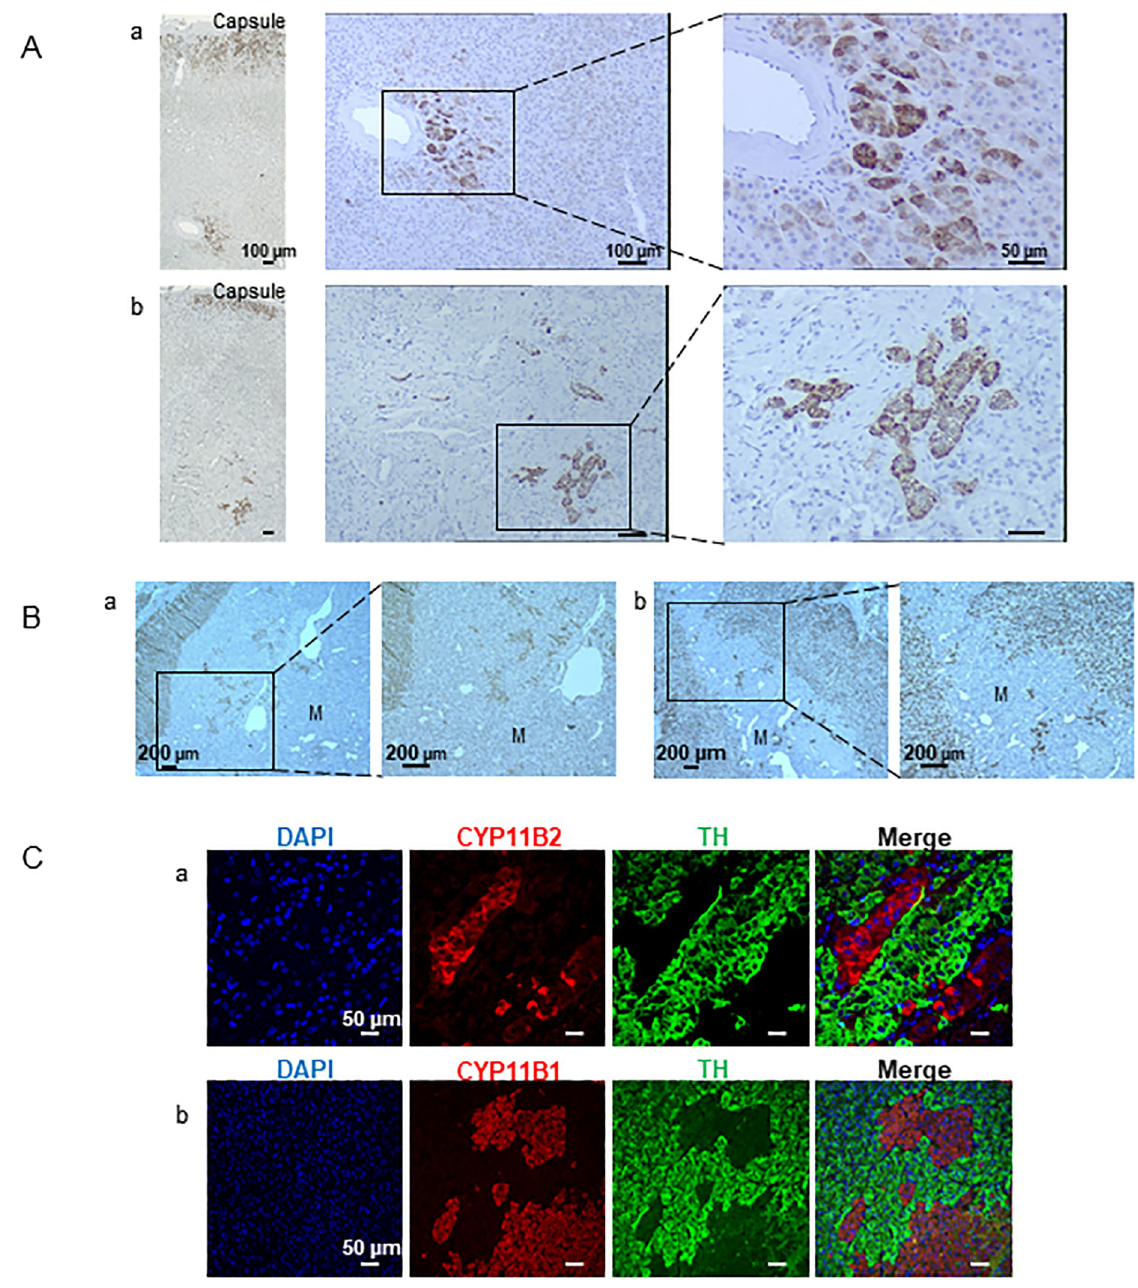
Fig 5. Ectopic localization of steroidogenic cells in the adrenal gland. (A) CYP11B2 immunostaining reveals that organized islets or isolated functional ZG cells can be identified in the vicinity of the central vasculature in the adrenal cortices of a 49-year-old man (a) and a 52-year-old woman (b). The left composite microphotographs show immunoreactivity for CYP11B2 throughout the cortex. (B) Immunostaining for SF1 highlights the occurrence of steroidogenic cells in the medulla (M). The adrenal medulla appears to be invaded by single or clusters of SF1-expressing cells. (a) 30-year-old man. (b) 72-year-old woman. (C) Double immunofluorescence for Tyrosine hydroxylase (TH) and either CYP11B2 or CYP11B1. The CYP11B2 (a) and CYP11B1 (b) positive cells are found within the adrenal medulla in close contact with the chromaffin cells. (a) 45-year-old man. (b) 64-year-old woman.